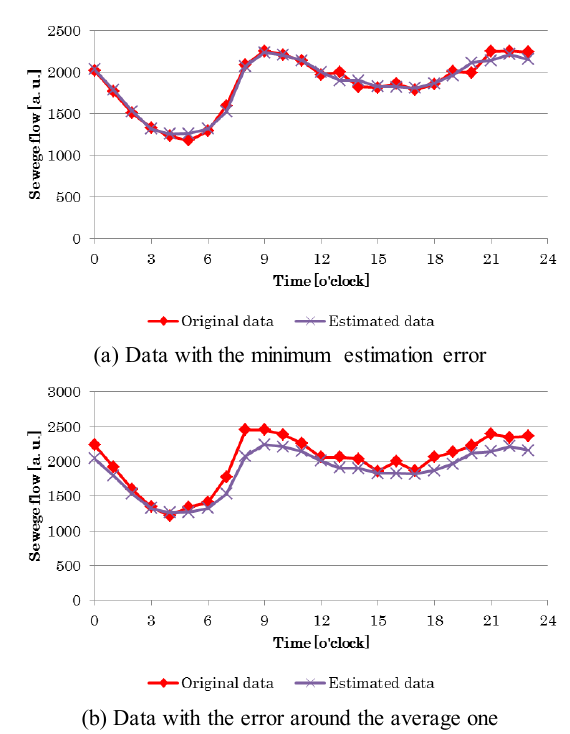
Fig. 6. Estimation of flow patterns without considering day types.